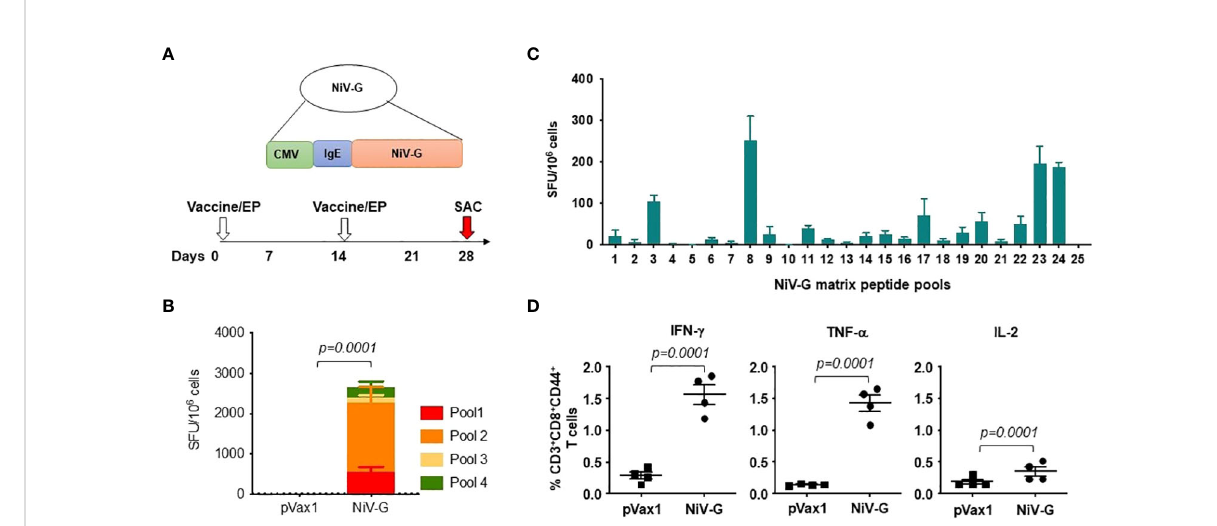
FIGURE 2 Functional pro fi le of cellular responses elicited by NiV-G vaccine in mice. (A) Schematic representation of EP mediated immunization and immune analysis. C57BL/6 mice ( n=4 per group) were immunized with 25 m g of pNiV-G vaccine using EP mediated enhanced delivery. (B, C) Immunization of mice with NiV-G vaccine induced robust T cell responses, as assessed by total IFN- g ELISpot assay on splenocytes stimulated with each of 4 pools of linear overlapping peptides spanning the whole NiV-G (B) and characterization of NiV-G-speci fi c dominant epitopes in C57BL/6 mice. IFN- g responses were assessed by ELISpot assays with matrix pools of NiV-G peptides where each 15-mer peptide was present in two pools (C) . The data represents the total IFN- g response of mean±SE in each group two weeks after the second immunization (day 28). Values represent mean responses in each group ( n=4 ) ± SEM. (D) Immunization with NiV-G vaccine induced activated CD8 + T cells capable of producing IFN- g , TNF- a and IL-2 secreting cells when stimulated by NiV-G peptides. Two weeks after the